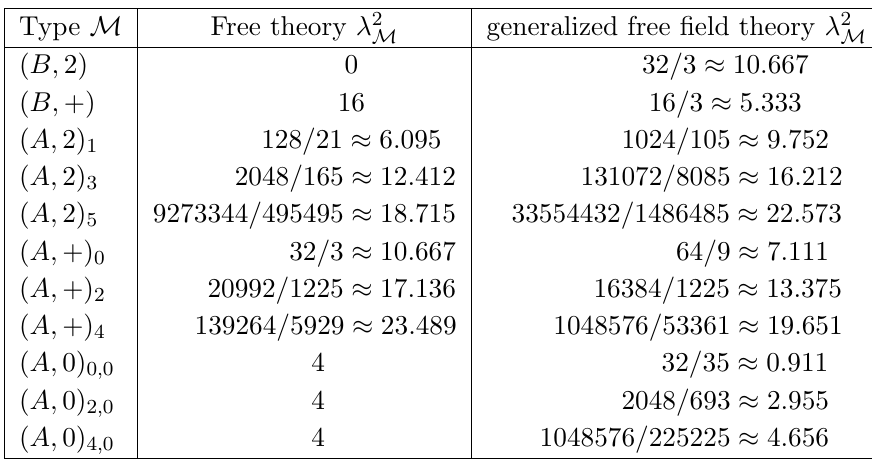
Table 3 . Values of OPE coe(cid:14)cients in the free and generalized free (cid:12)eld theory limits for the ( B; 2) and ( B; +) multiplets, the ( A; 2) j multiplet for spin j = 1 ; 3 ; 5, the ( A; +) j multiplet for j = 0 ; 2 ; 4, and the ( A; 0) j;n multiplet for j = 0 ; 2 ; 4 and n = 0, which is the lowest multiplet with that